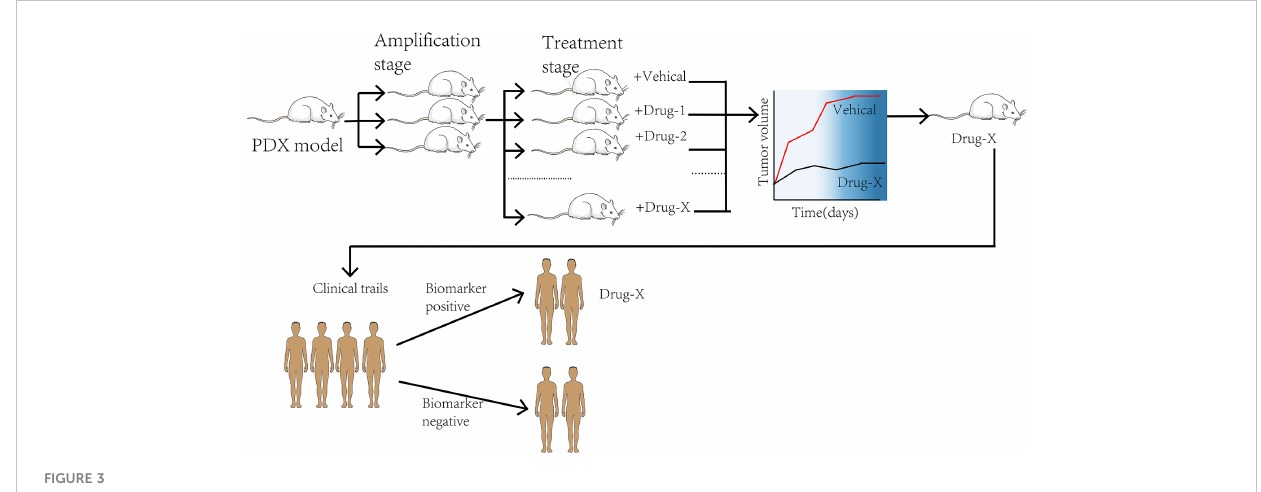
FIGURE 3 The process of co-clinical